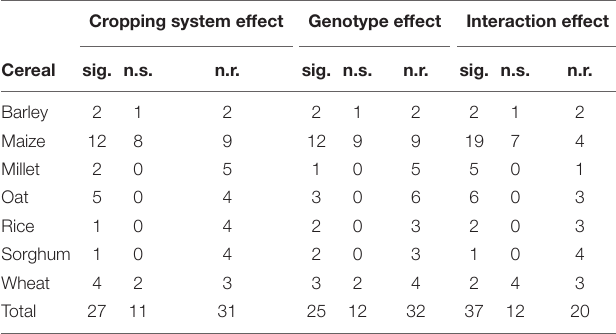
TABLE 4 | Number of studies reporting significant and non-significant genotype, cropping system, and interaction effects, categorized by cereals. Cropping system effect Genotype effect Interaction